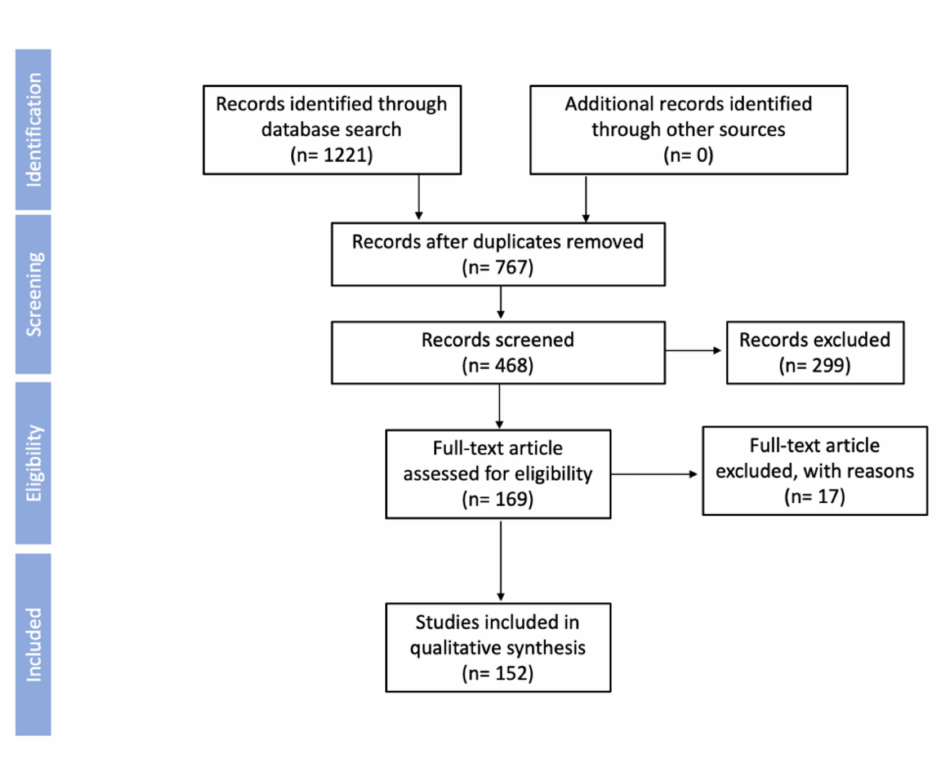
Figure 2. PRISMA flow